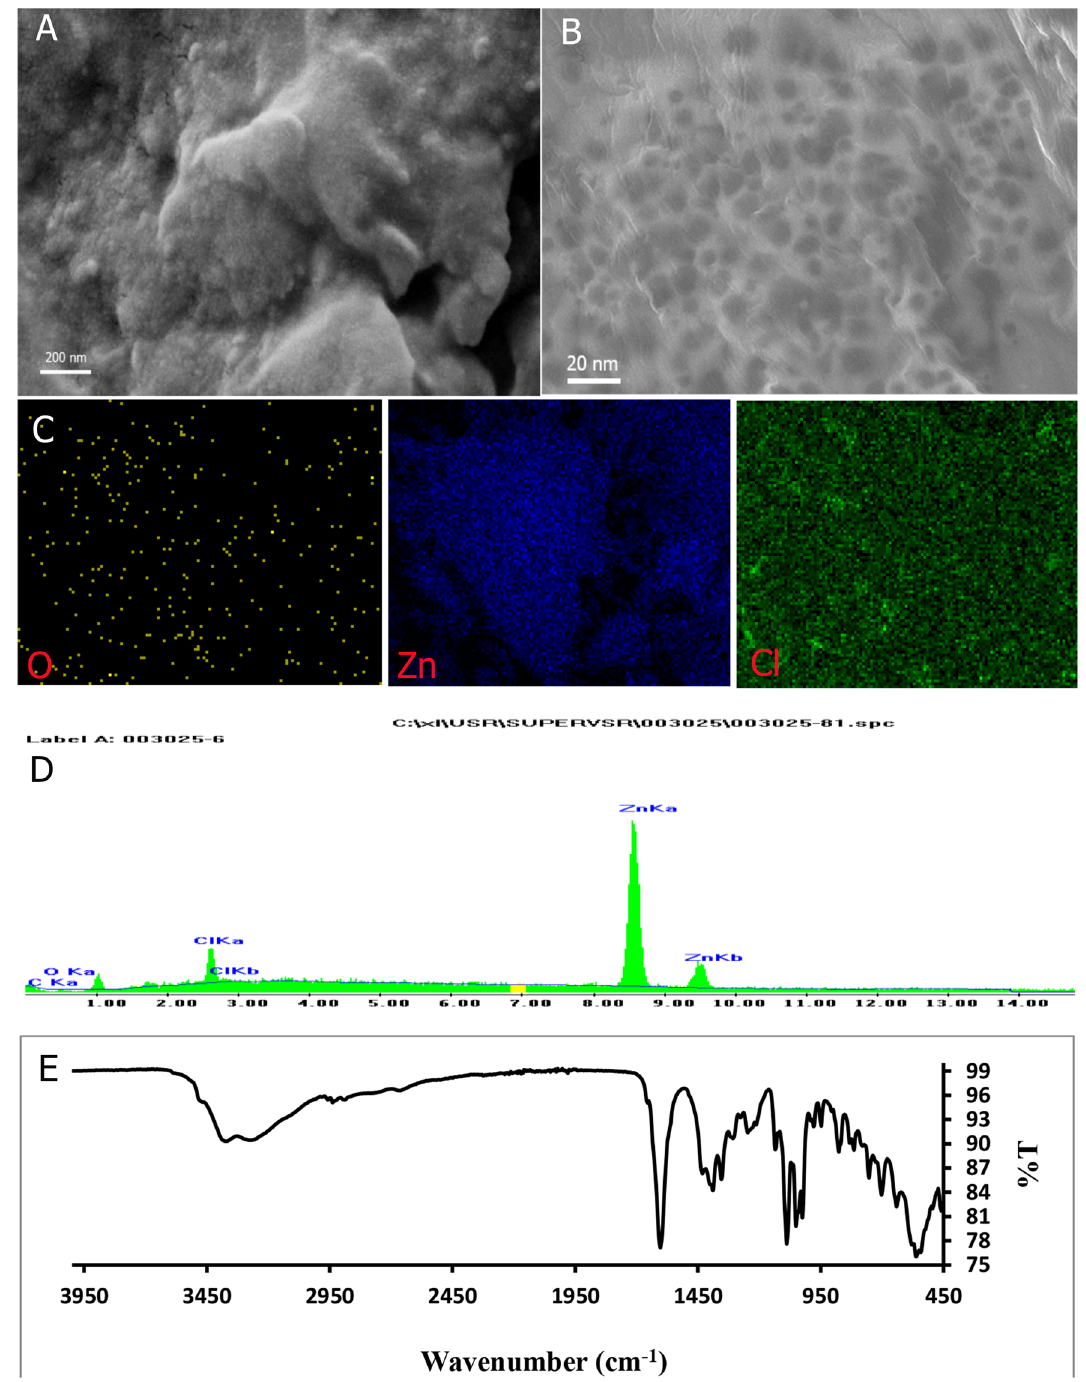
Figure 1. ( A ) FE-SEM ( B ) HR-TEM. ( C,D ) EDX elemental mapping and ( E ) FT-IR spectra of